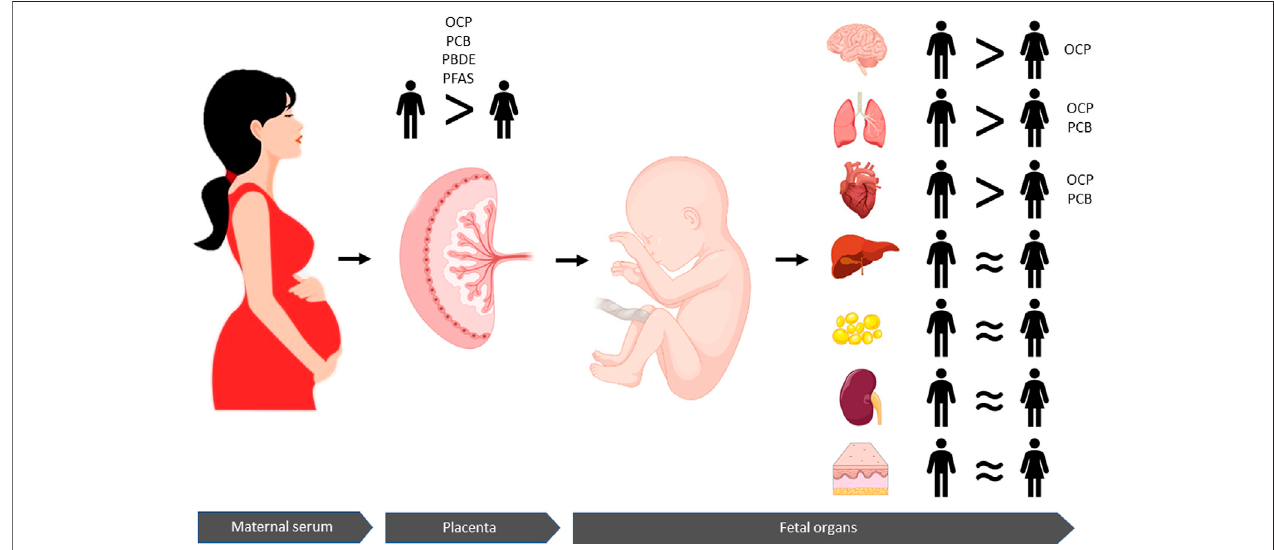
FIGURE 1 | Persistent organic pollutants (POPs) are transferred from the maternal circulation via the placenta to the fetus and accumulate in different fetal organs. ConcentrationsofOCPs,PCBs,PBDEs,andPFASsarehigherinhumanplacentaswithmalefetusescomparedtoplacentaswithfemalefetuses.Moreover,thissexually dimorphic patten is re fl ected in the fetal organs where higher concentrations of OCPs accumulate in males ’ in brain, lung and hearts tissues than those of females. Concentrations ofPCBs arealso higher inmale lungs and heart tissues than females. Similar concentrationsofPOPsarefound inliver, fat, kidney,and skin tissues frommaleandfemalefetuses.Takentogether,these fi ndingssuggestthatmalefetusesareoverallmoreexposedtoPOPsthanfemalefetuses,whichmaybeassociated with sexual dimorphic risks.